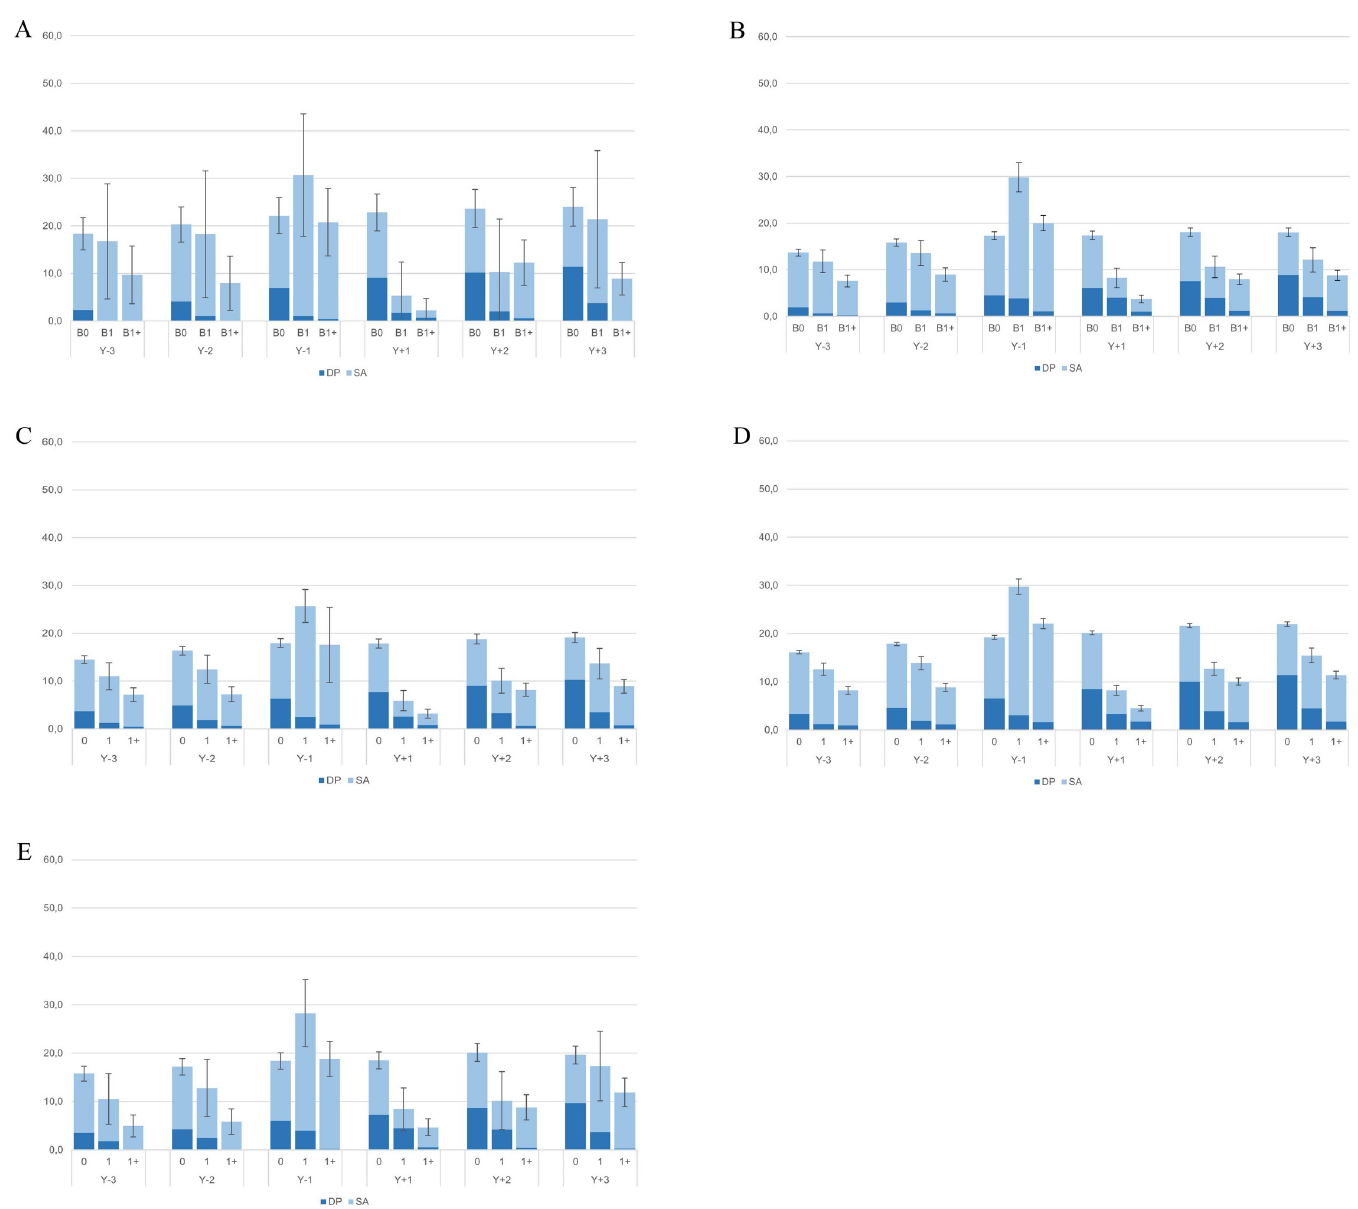
Fig 2. Standardized mean sickness absence (SA) and disability pension (DP) net days/year and 95% confidence intervals within the (1a) extremely male-dominated, (1b) male-dominated, (1c) gender-integrated, (1d) female-dominated, (1e) extremely female-dominated groups, by childbirth group and study year.